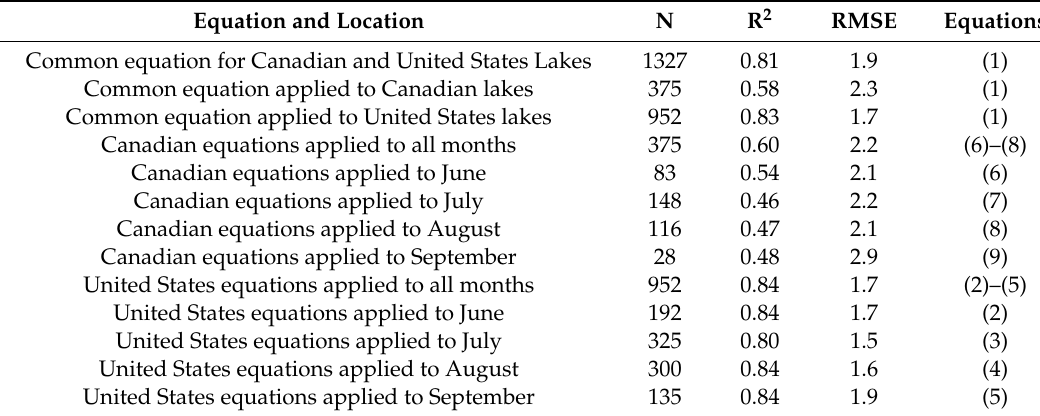
Table 6. Strength of relationships between predicted water temperatures ( ◦ C) at 1-m in United States and Canadian lakes based on regressions of measured water temperatures on predicted temperatures using the testing data sets. The common equation was first applied to the Canadian and United States lakes combined and the same equation was then applied to the Canadian and United States lakes separately. Separate equations were developed by month for the Canadian lakes and the results are presented for all months combined and for the four summer months separately. The same was done for the United States lakes. Equation and Location RMSE Equations Common equation for Canadian and United States